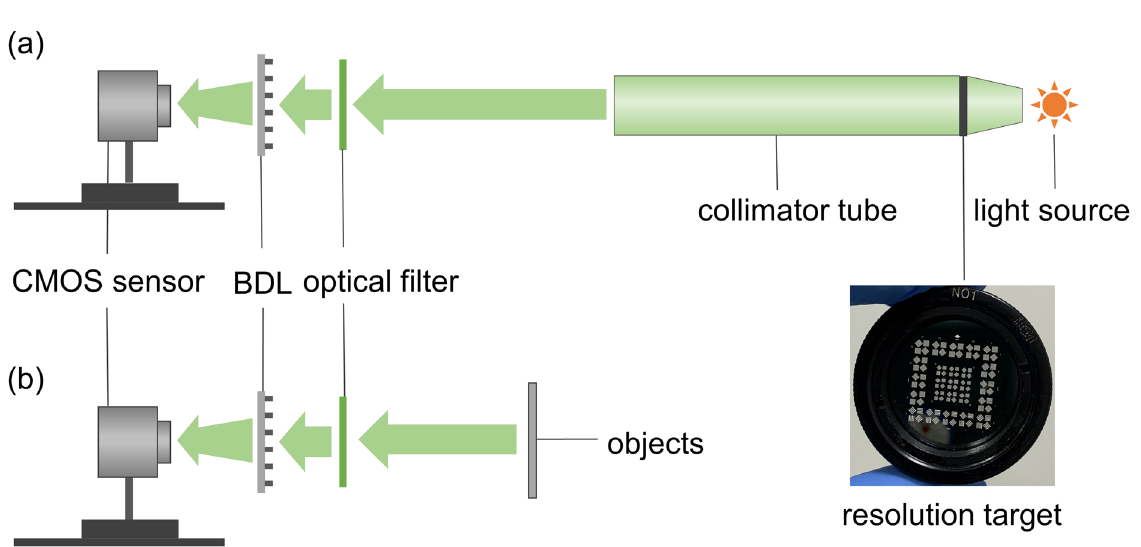
Figure. 4. Diagram of experimental setups. ( a ) Schematic diagram of the resolution testing experiment setup. ( b ) Schematic diagram of the actual objects imaging experiment